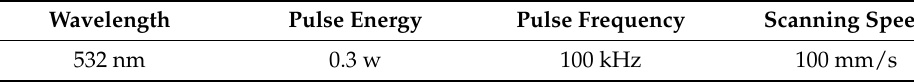
Table 2. Laser processing parameter. Table 3. Parameters of